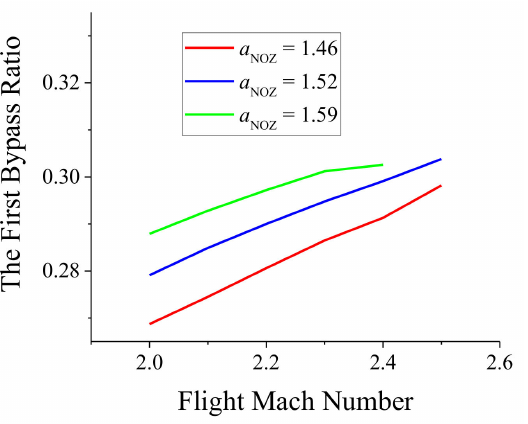
Figure 24. The Variations of The First Bypass Ratio at the conditions of Different Throat Area Coefficients of Main Nozzle ( α NOZ ).